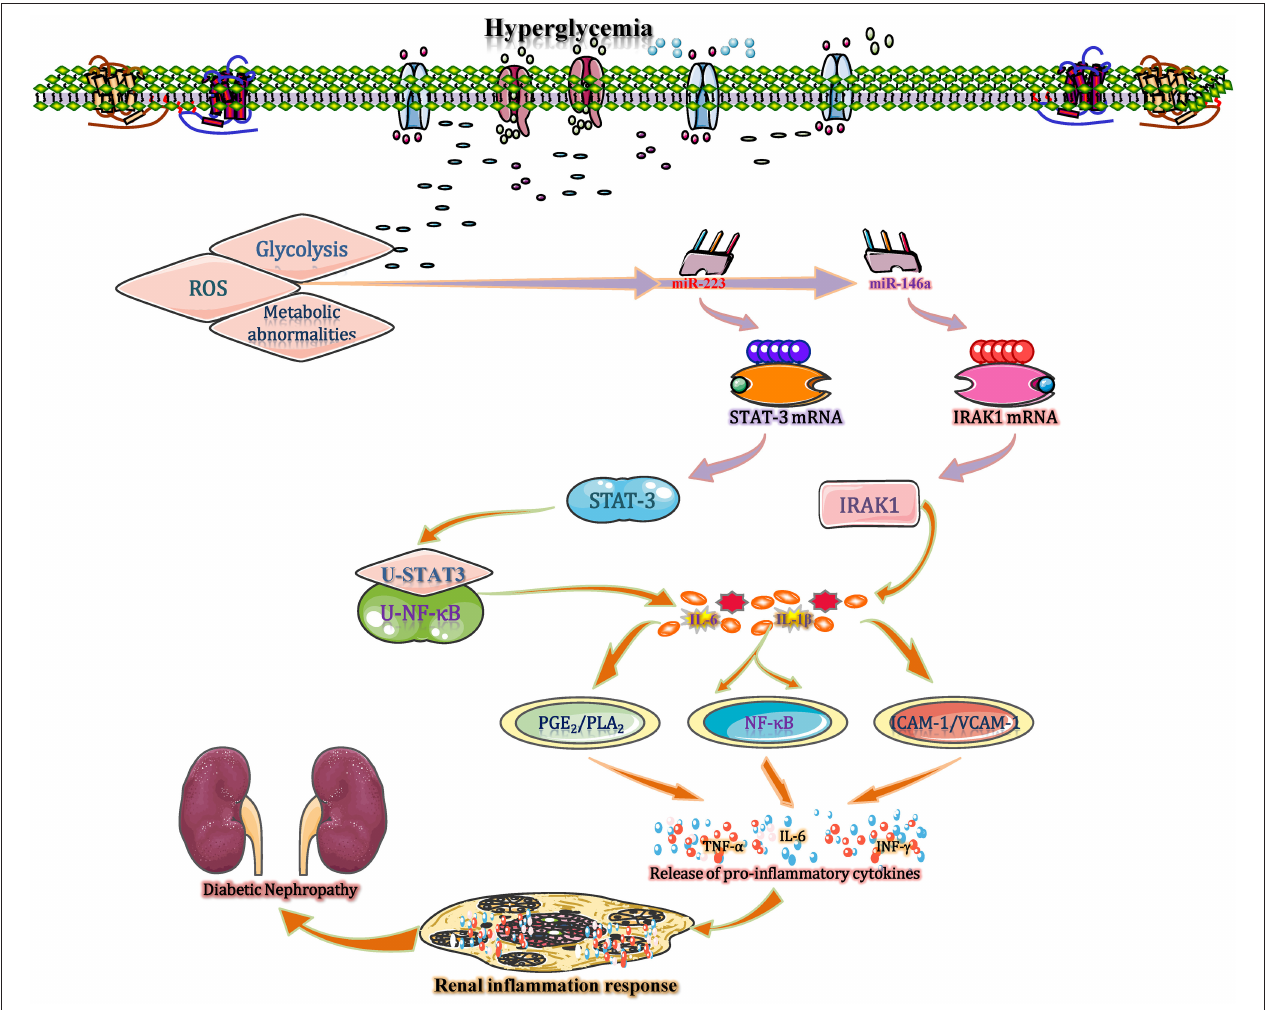
FIGURE 5 | miRNAs interfere with inflammation in DN by regulating interleukin 1. In diabetic kidneys, sustained hyperglycaemia leads to increased glycolysis, ROS production, and the activation of multiple metabolic abnormalities, resulting in a significant increase in miR-223 expression. miR-223 is a non-conserved miRNA that putatively targets the 3 ′ -UTR of STAT3 to regulate its posttranscriptional processing. The un-phosphorylated STAT3 (U-STAT3) combined with un-phosphorylated NF- κ B (U-NF- κ B) to form a complex and then bind to the κ B element site of promoters for transcription of genes, such as IL-1 and IL-6, eventually increase the IL-1 accumulation and amplify the inflammatory response. Moreover, the reduction in miR-146a in kidney tissue increases IL-1 expression with positive feedback regulation and enhances inflammatory responses. In contrast, miR-544 significantly attenuates IL-1 production to ameliorate diabetic renal inflammation by directly targeting fatty acid synthase. PGE2, prostaglandin E2; PLA2, phospholipase A2; U-STAT, unphosphorylated signal transducers and activators of transcription; VCAM-1, vascular cell adhesion